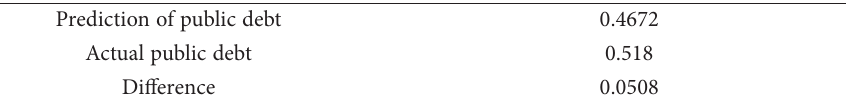
Table 4. Public debt in 2017 (prediction and real value) (source: own data processing in R program according to Eurostat, n.d. data) Prediction of public